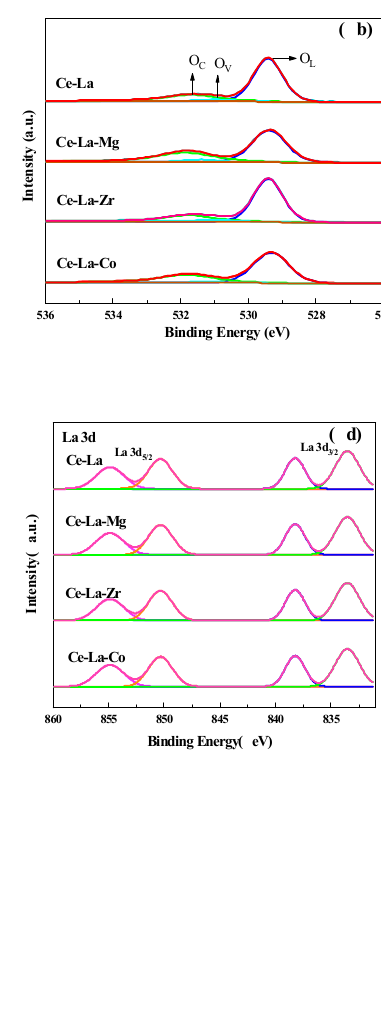
( ∼ 898.3 eV), V (cid:48)(cid:48) ( ∼ 888.9 eV), V (cid:48) ( ∼ 884.9 eV), and V ( ∼ 882.4 eV) represent the spin-orbit